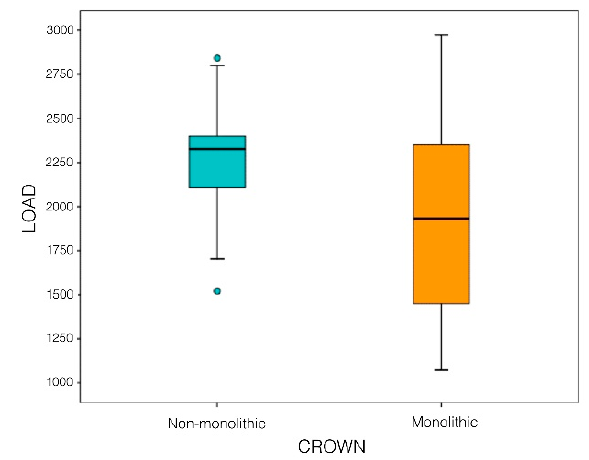
Figure 4. Box-plot shows fracture resistance in different groups.